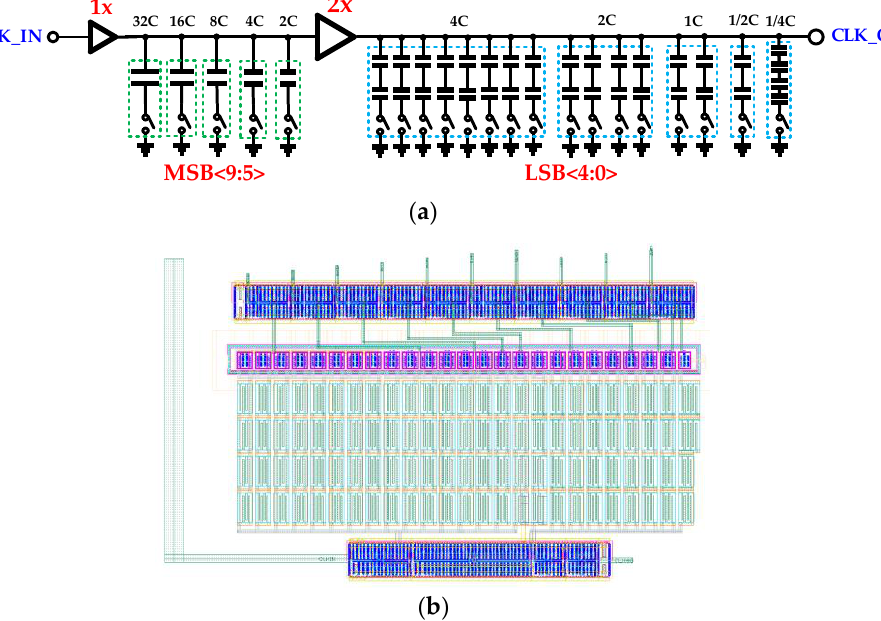
Figure 11. ( a ) Schematic and ( b ) layout of the MF-VDL.